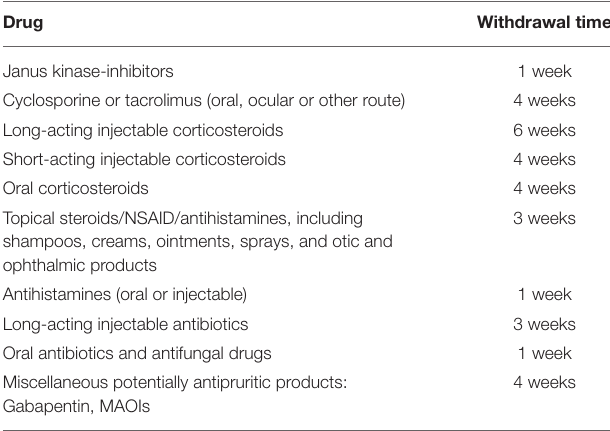
TABLE 1 | Prohibited medications and their withdrawal time prior to study enrollment.